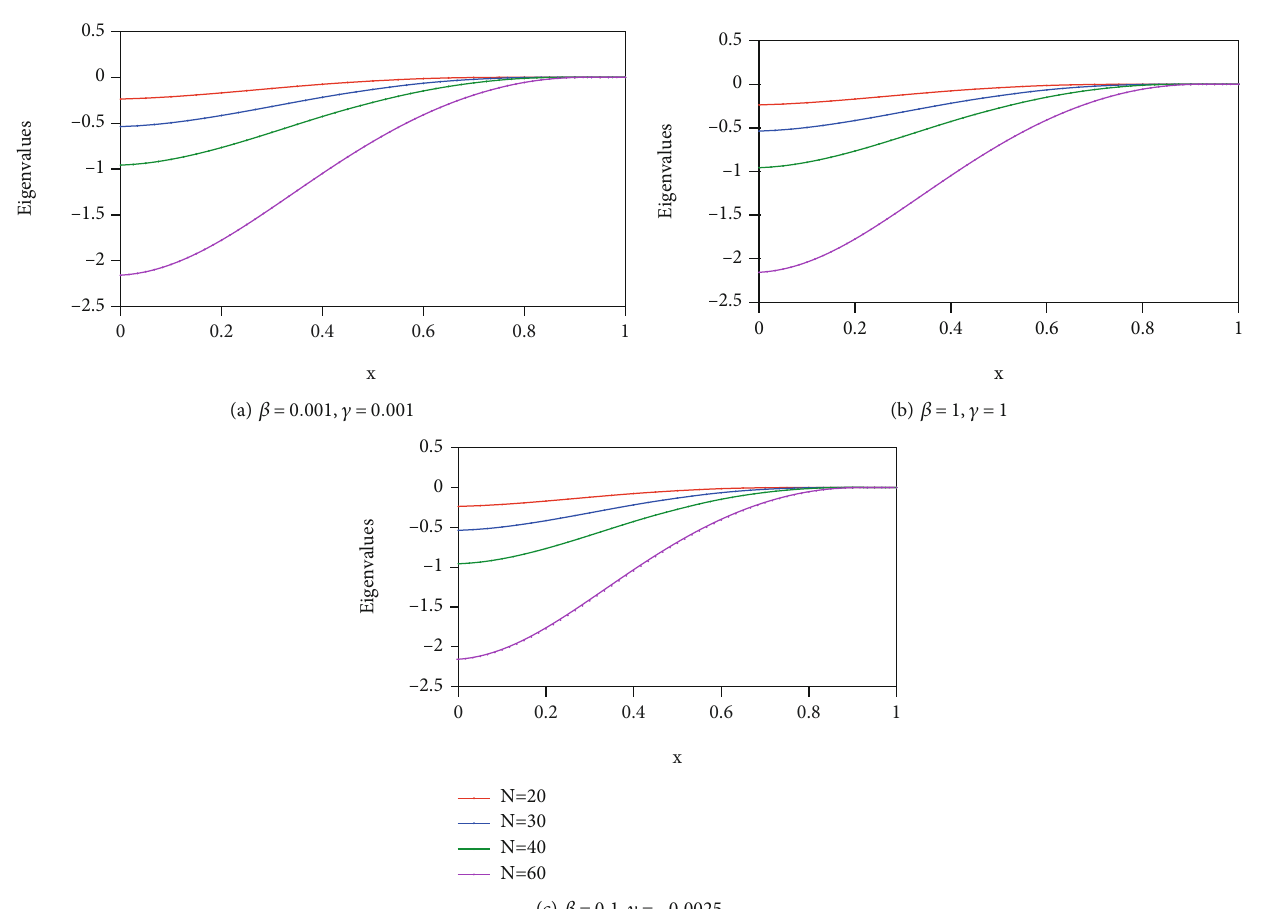
Figure 1: Plot of eigenvalues corresponding to gBF equation with Δ t = 0 : 0001 and δ = 8